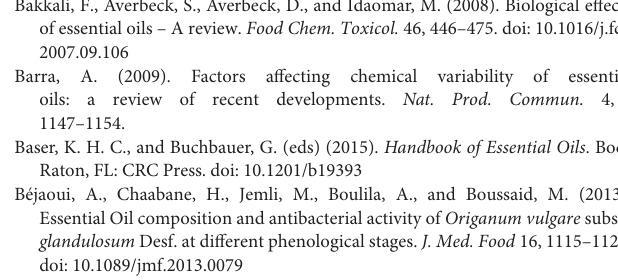
Supplementary Figure 1 | Flow diagram of the experimental procedures described in section “Treatments Applied at the Same Time With Inoculation of ZYMV or ToLCNDV”—“Treatments Applied at the Same Time With Inoculation of ToLCNDV (Time Course)” (flow A ), and in section “Treatments Applied After Inoculation of ToLCNDV (Time Course)” (flow B